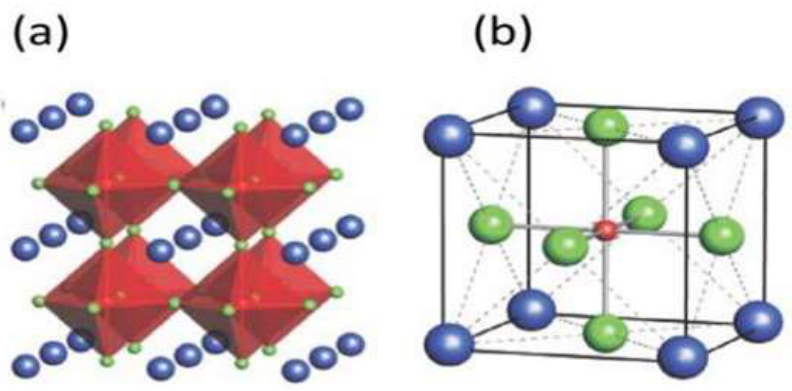
Figure 1: Perovskite cubic structure ABO 3 , (a) Three dimension perovskite structure,(b) Cubic close packed structure